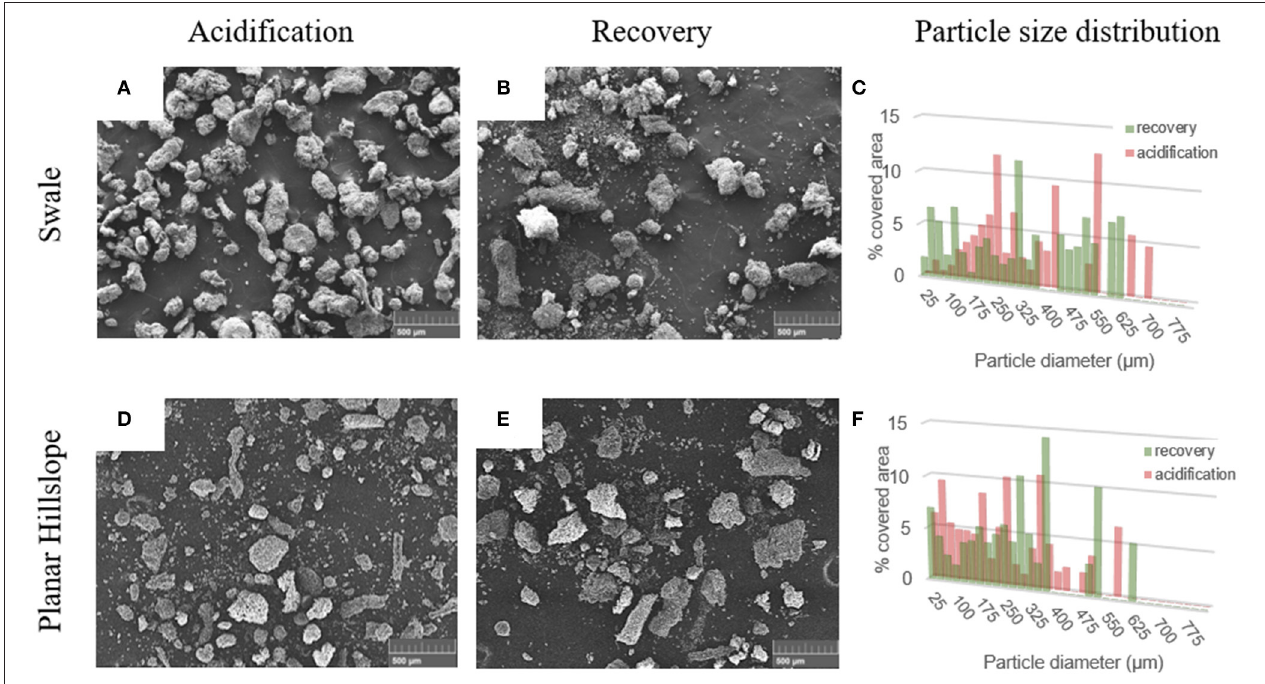
FIGURE 10 | Secondary electron scanning electron microscopy (SE SEM) images of soil aggregates taken from a swale (A,B) and planar hillslope (D,E) in the Susquehanna Shale Hills Critical Zone Observatory (SSHCZO) after treatment with laboratory acidification (A,D) and recovery (B,E) solutions. Particle size distribution from image analyses for swale (C) and planar hillslope (F) aggregates are expressed in % covered area (i.e., the area that is covered by particles that belong to a given size